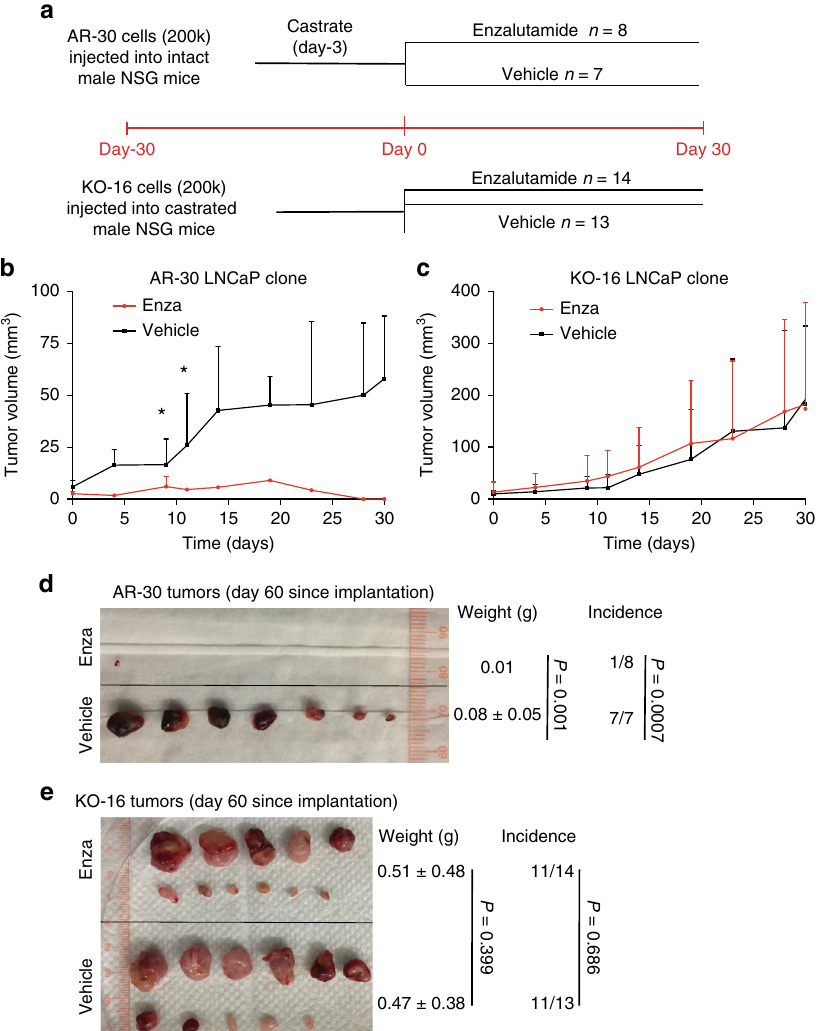
Fig. 5 AR-KO LNCaP resist Enza in vivo. a Experimental scheme for in vivo Enza treatment (also see METHODS). Top: scheme for experiments using AR- 30 LNCaP clones, in which animals were castrated 3 days before the start of Enza treatment (30 mg/kg/week, i.p). Bottom: scheme for experiments in which KO-16 cells were implanted in castrated NSG mice and Enza treatment was commenced 30 days thereafter. Both experiments were terminated on day 30 since the start of Enza treatment (i.e., day 60 since the tumor cell implantations). b , c Growth curves (by measuring tumor volumes) showing that AR + LNCaP clones were sensitive ( b ) whereas AR-KO clones were resistant ( c ) to Enza. In b, * P < 0.01 (Student ’ s t -test; note that starting from the 4 time point, i.e., day 15, there was only one tumor remaining (see d) and therefore statistics could not be performed). d , e Endpoint tumor images showing that AR + LNCaP cells are sensitive ( d ) whereas AR-KO cells are refractory ( e ) to Enza treatment in vivo. Also shown are tumor weight, incidence and P values (determined using unpaired Student ’ s t -test and χ 2 test for tumor weight and incidence,